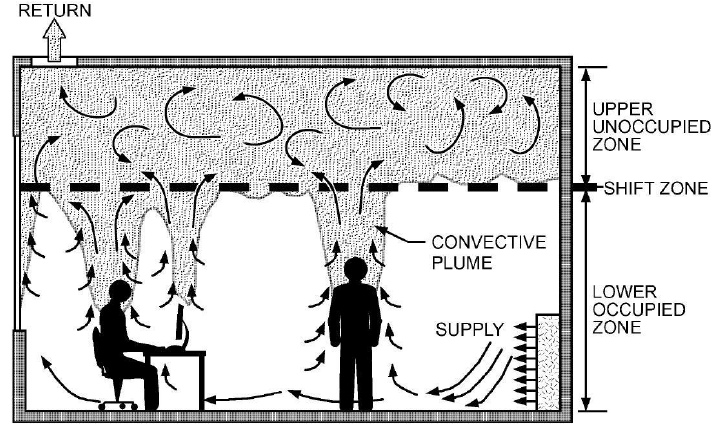
Figure 2. Thermal displacement ventilation system characteristics